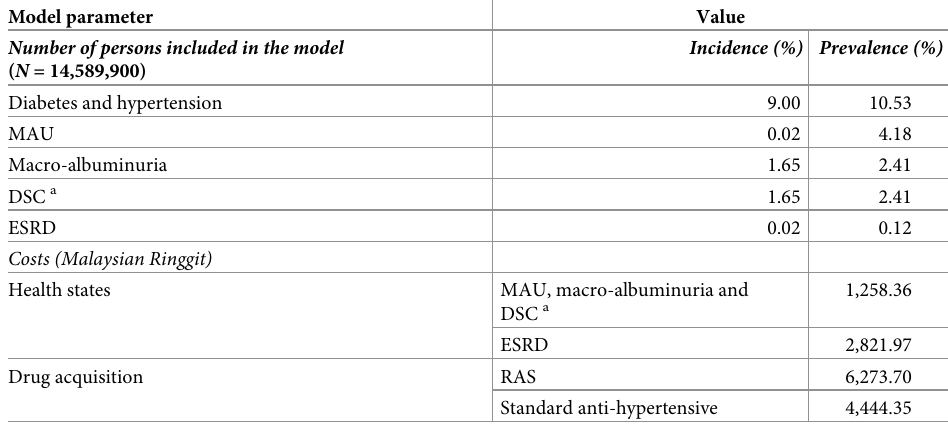
Table 1. Base-case scenario for a budget impact analysis of adding drugs that inhibit renin-angiotensin system to standard antihypertensive treatments for patients with hypertension and diabetes in Malaysia. Model parameter Number of persons included in the model ( N =